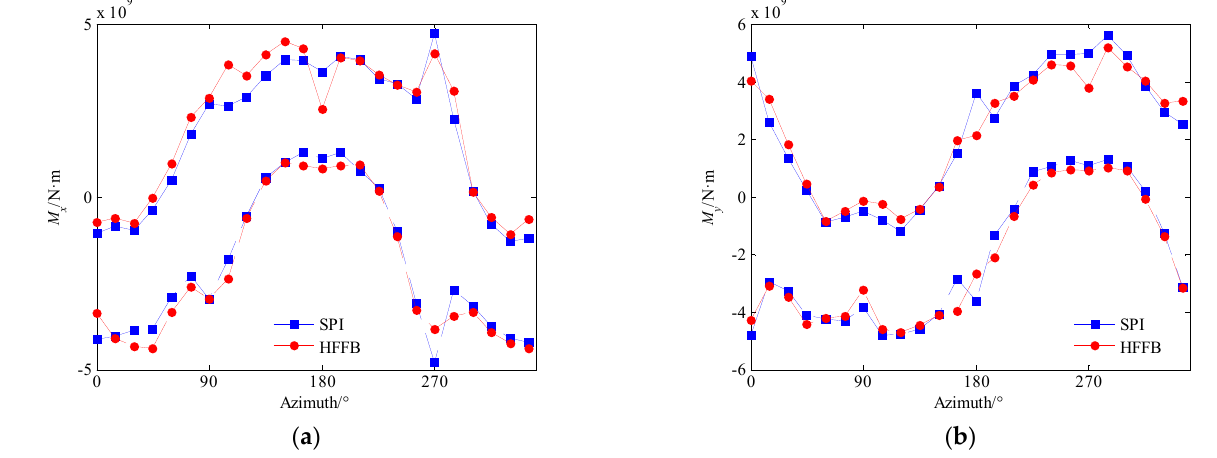
Figure 11. Comparison of extreme base overturning moments of HFFB and SPI: ( a ) M x . ( b ) M y .